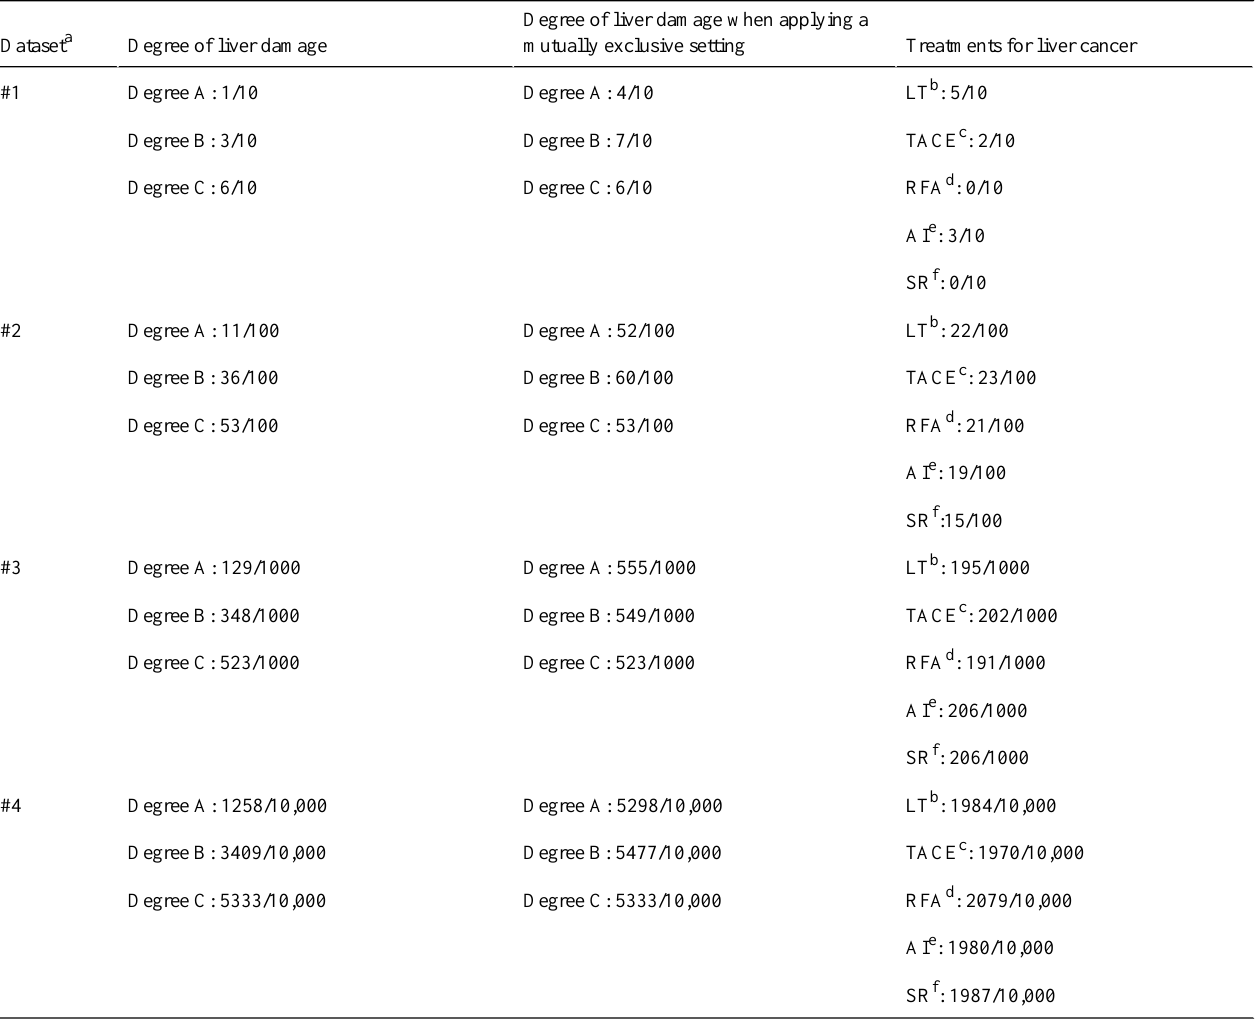
Table 2. The distribution numbers of patients in four datasets that are randomly generated by the clinical data generator.